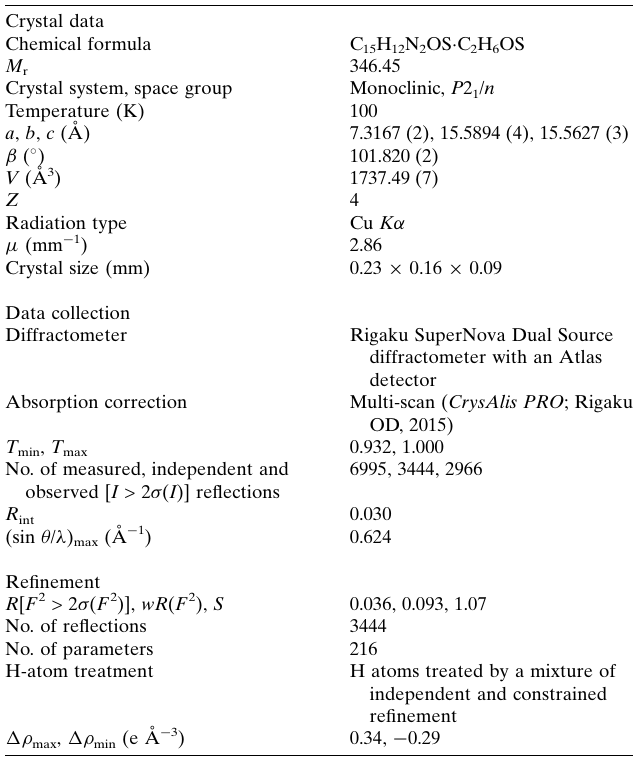
Table 2 Experimental details. Crystal data Chemical formula